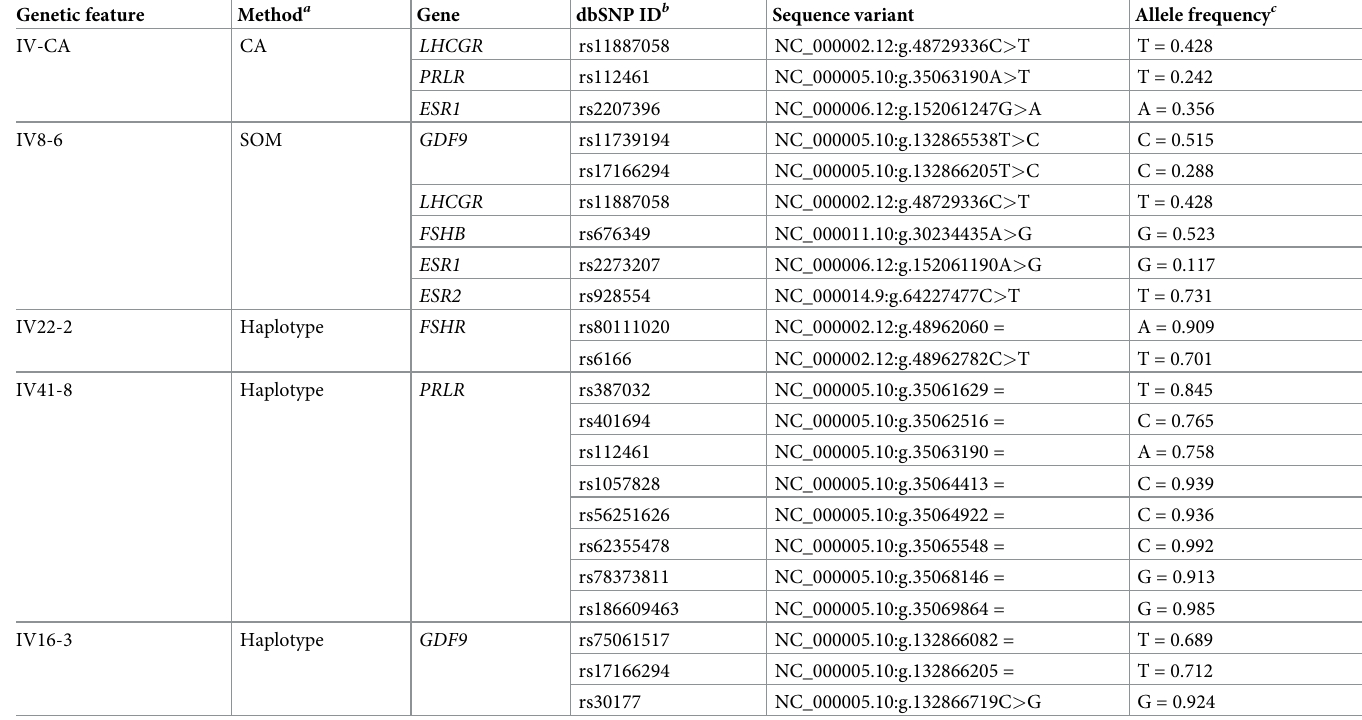
Table 2. Genetic features identified as important for the prediction of the number of MII oocytes after ovarian stimulation. Genetic